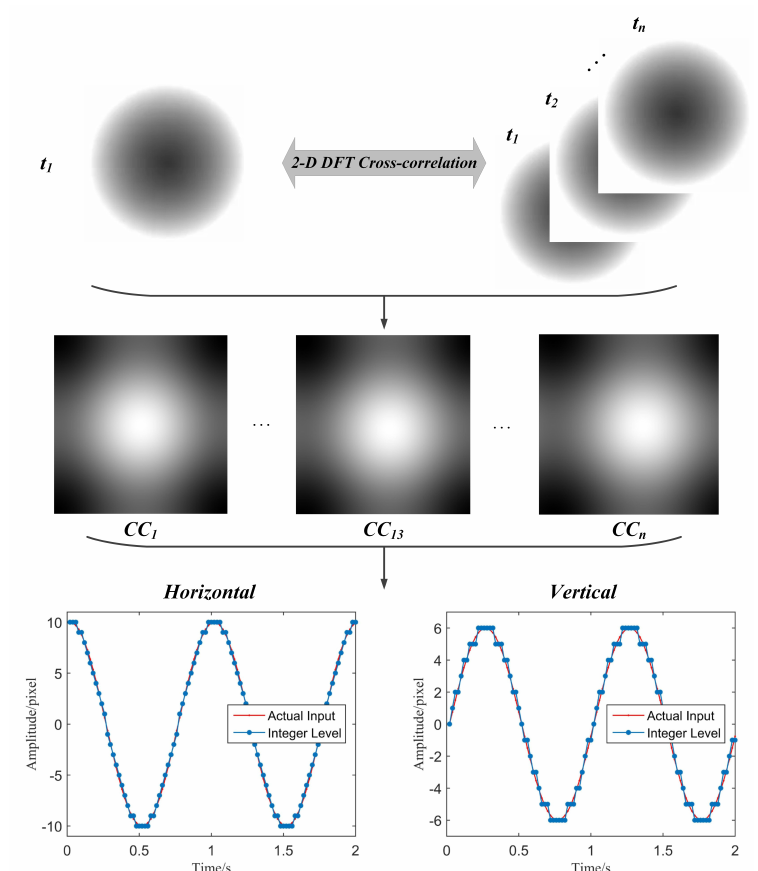
Figure 3. Procedure of maximum cross-correlation (MCC) motion extraction algorithm in 2D frequency